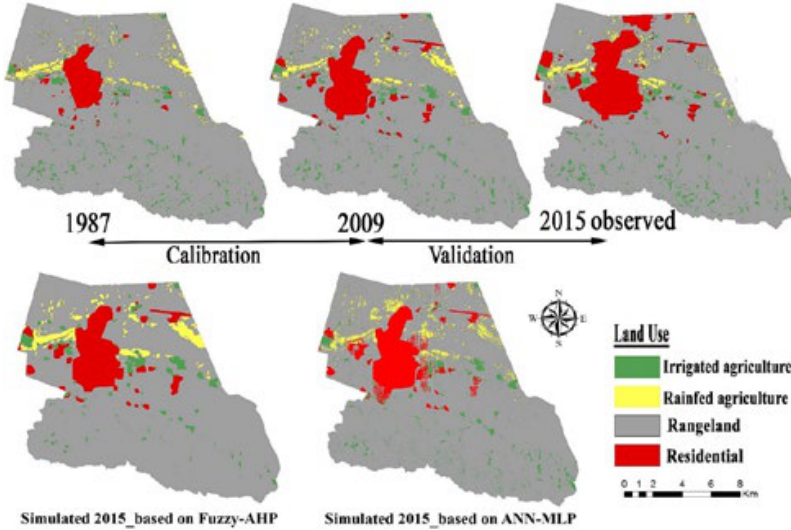
Fig. 5: Land use maps in calibration and validation periods